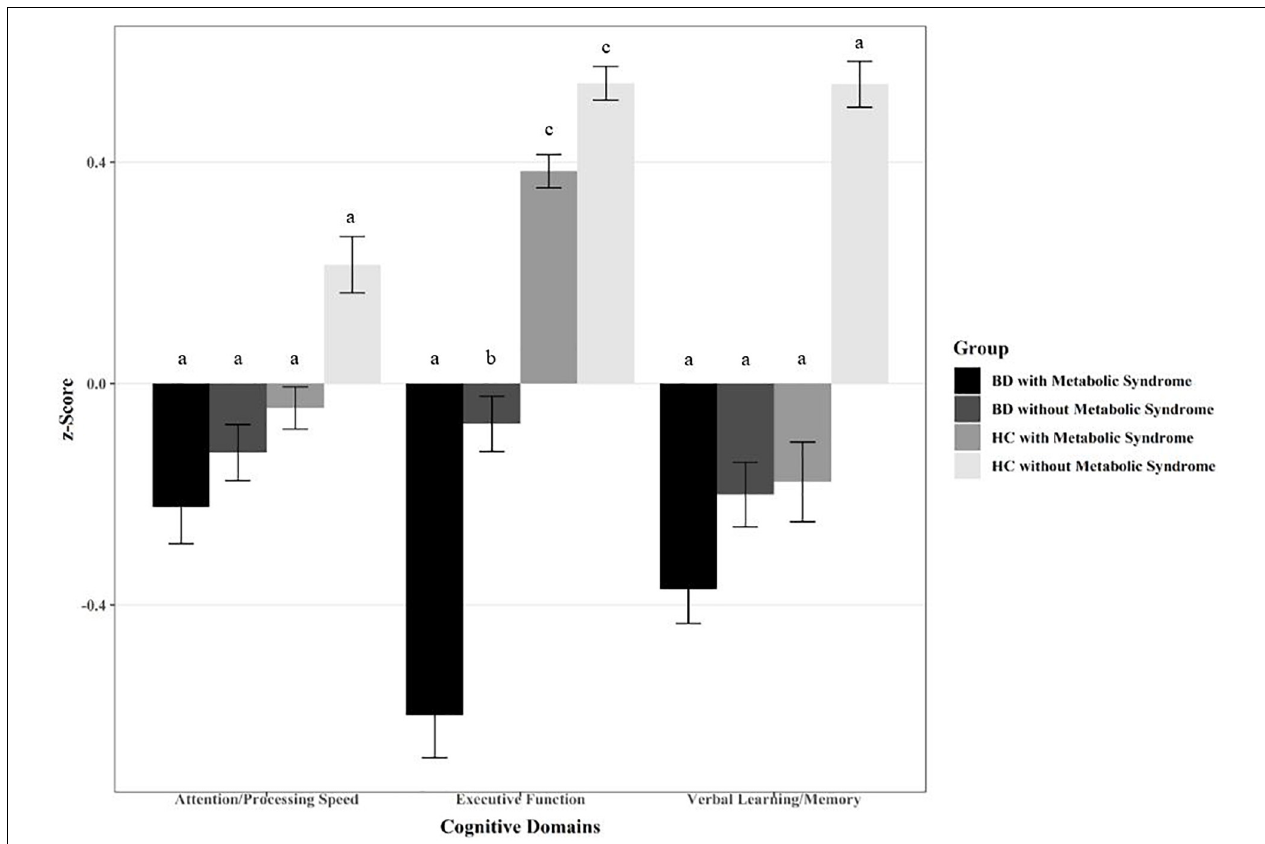
FIGURE 1 | Differences in cognitive domains in individuals with bipolar disorder (BD) with and without metabolic syndrome (MetS) in comparison with healthy controls (HC) with and without MetS. Different letters indicate significant mean differences at p <